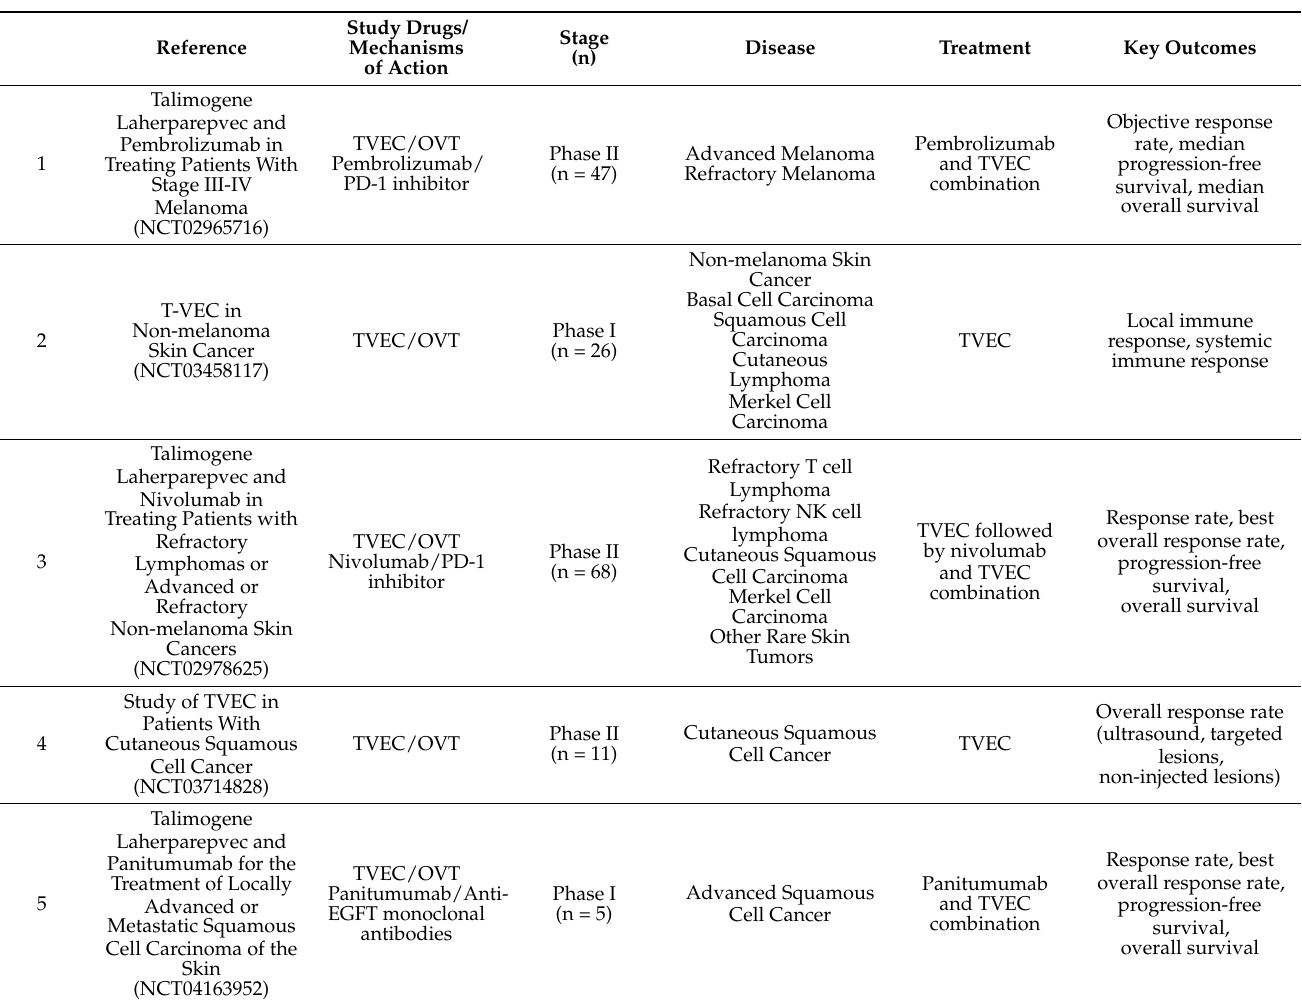
Table 2. Ongoing clinical trials of T-VEC in skin